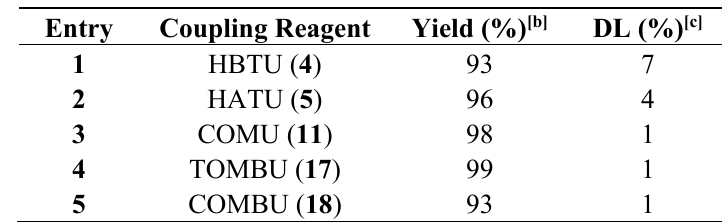
Table 3. Yield and racemization during the formation of Z-Phg-Pro-NH 2 ( 24 ) (solution-phase synthesis) [a] .